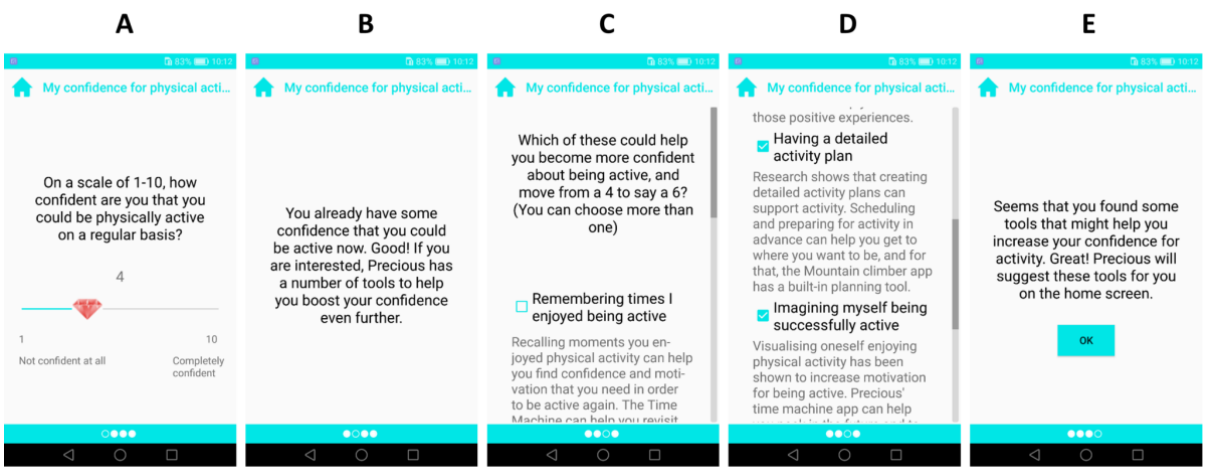
Figure 7. Implementation of the Confidence Ruler tool. Screen A shows the main question of this tool, which is followed up with a tailored reflection on Screen B. Screens C and D show a number of the tools available to users and the rationale for how each could help improve their confidence. Users were free to select as many or as few of these as they wished.